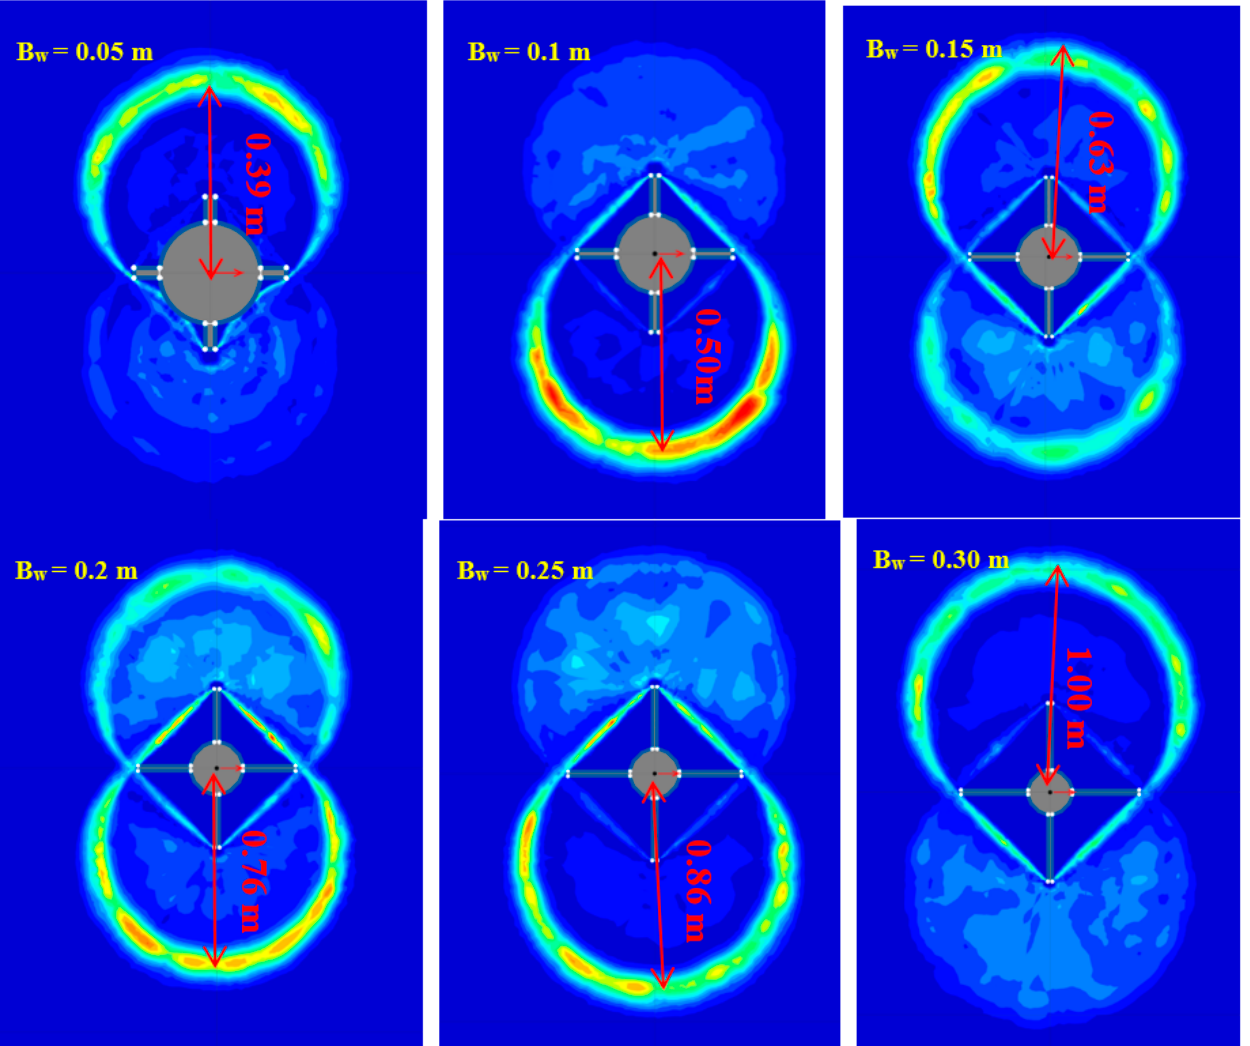
Figure 12. Influence of various wing widths B w on the shear plastic zone of the soil around the four-wing pile when lateral-load angle β = 0 and pile–soil interaction coefficient a = 0.4. The influence of the pile–soil interaction coefficient on the ULC of the four-wing pile, (calculated by OPTUM G2) was studied. The calculation model for the four-wing pile is shown in Figure 3. The other model parameters were the same as those previously described. The relationship between the pile–soil interaction coefficient ( a ) and the normal- ized ultimate lateral capacity of the four-wing pile ( N F ) as a changed from 0 to 1, according to limit analysis, is presented in Figure